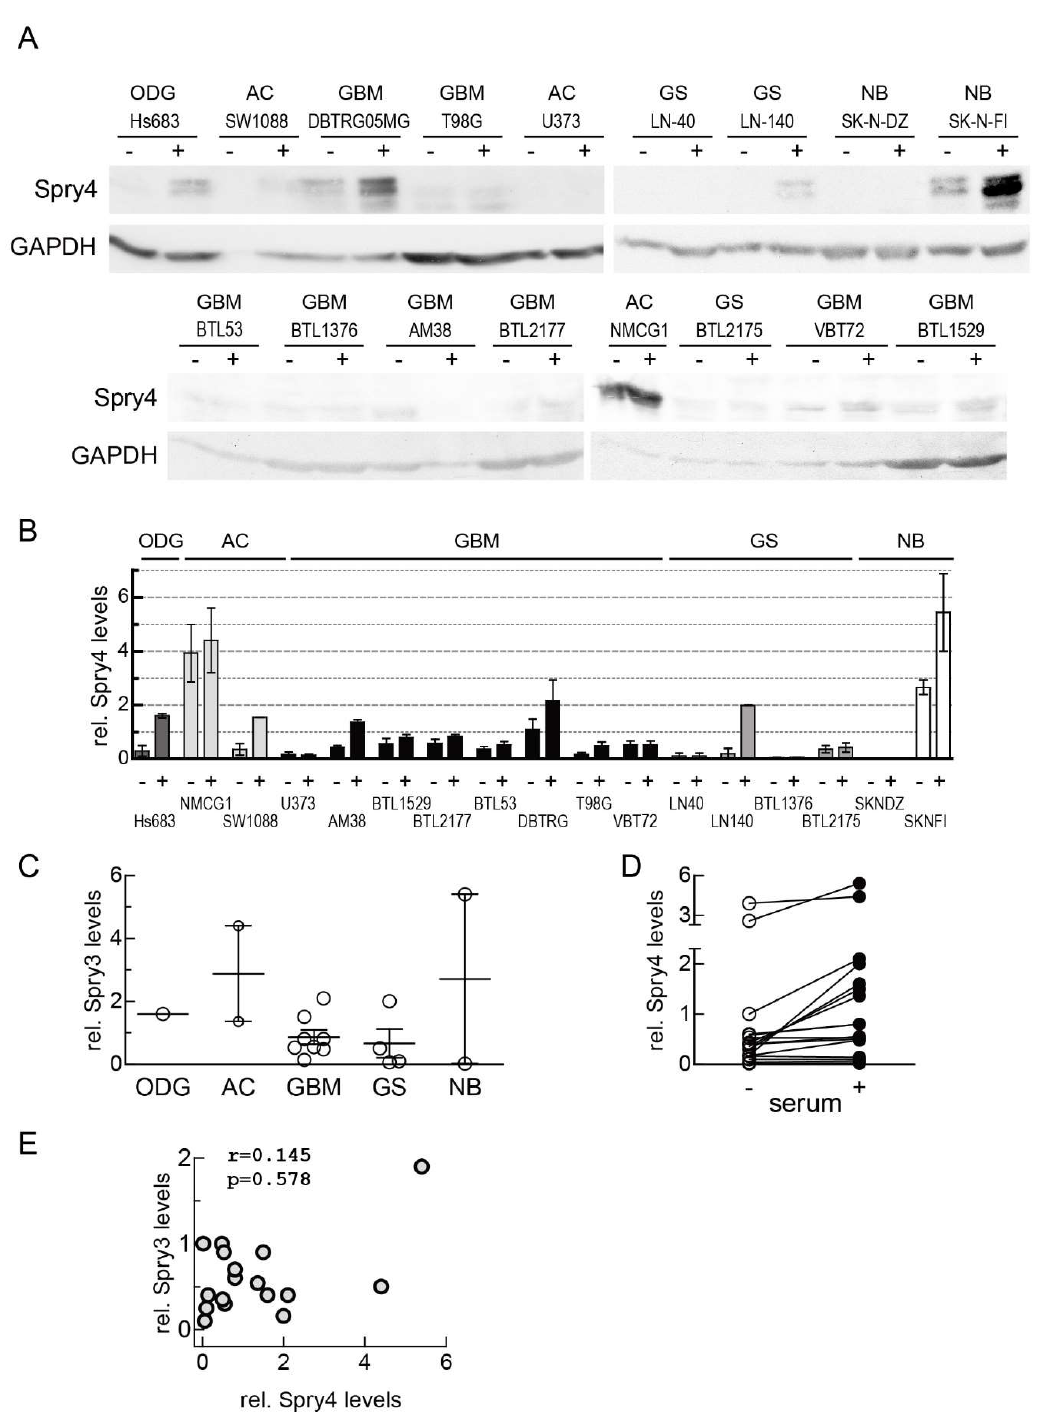
Figure 2. Expression analysis of endogenous Spry4 protein in brain cancer cells. ( A ) Spry4 protein levels in 17 brain cancer-derived cell lines which were cultured devoid of ( − ) and with ( + ) serum. GAPDH served as loading control. ( B ) Quantification of Spry4 was performed using Image Quant 5.0. An external control was arbitrarily set as 1 and loading differences were adjusted to GAPDH expression. A column graph summarizes the results of 2–3 independent experiments. ( C ) Spry4 expression in serum-supplemented growth condition was compared. A scattered dot-plot grouping the cells according to the histological origin is depicted. ( D ) A comparison of Spry4 levels detected in starved (open circle) and stimulated (closed circle) cells is presented. ( E ) Correlation of Spry3 and Spry4 expression was calculated using GraphPad